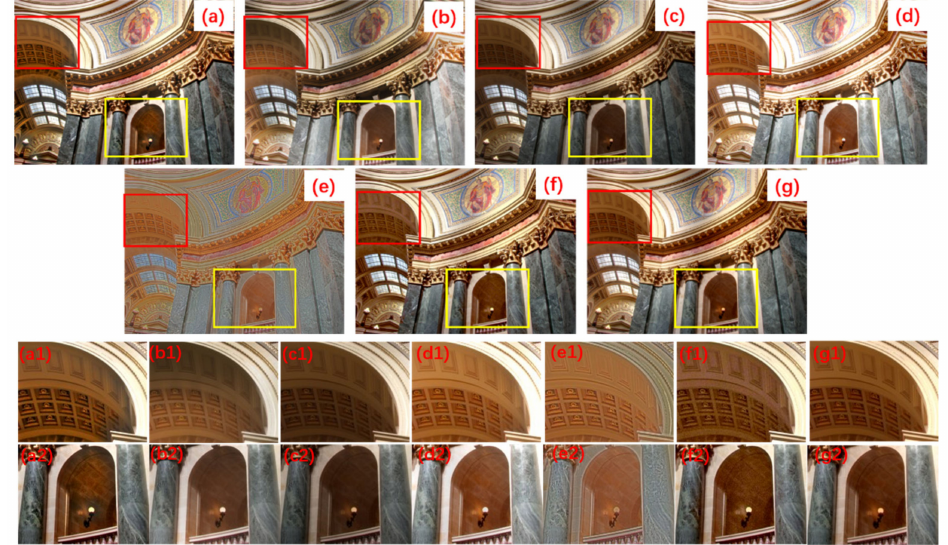
Figure 13. Comparison of fusion results for Figure 9d. ( a ) SPD-MEF method fusion result. ( b ) MRF method fusion result. ( c ) DSIFT method fusion result. ( d ) FEAF method fusion result. ( e ) B-LP method